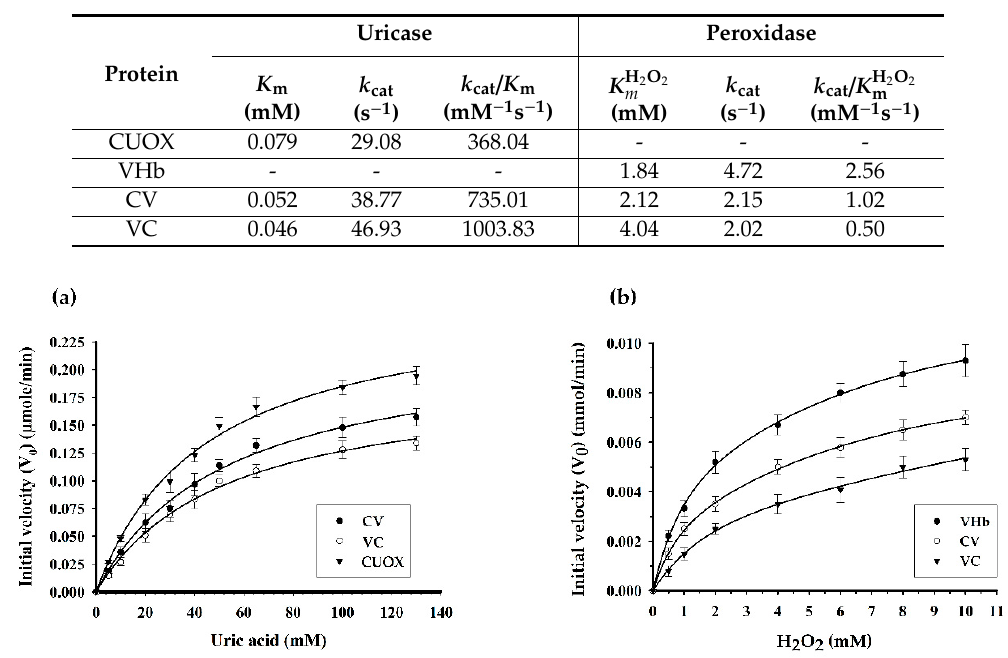
Table 2. Steady-state kinetics of the produced proteins.